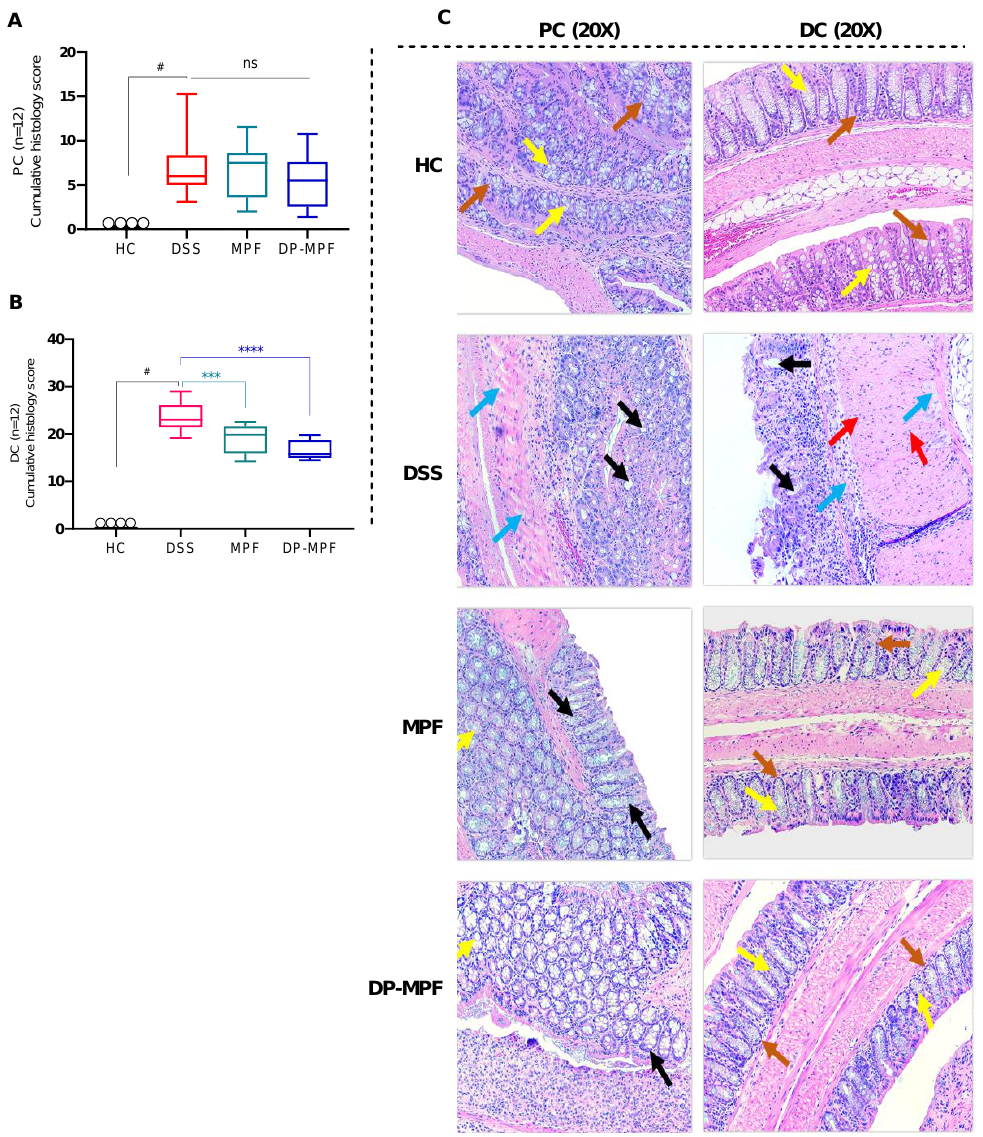
Figure 3. Effect of MPF and DP-MPF on histopathology in DSS-induced colitis. ( A , B ) Histopathological scores for each animal were calculated after microscopic analysis of tissue sections from the PC and DC. ( C ) Histological representation of PC and DC sections stained with haematoxylin and eosin (H&E) for healthy controls (HC), DSS-treated mice (DSS), MPF treated mice (MPF), and DP-MPF treated mice (DP-MPF) at 20 × magnification. Statistical significance was evaluated using one-way ANOVA followed by Tukey’s post-test. # Significant effect HC vs. DSS ( p < 0.05). A p -value of <0.05 was considered significant, ns indicates non-significance, *** p < 0.001 and **** p < 0.0001. Data expressed as a mean ± SEM ( n = 12/group). Arrows represent crypts/regeneration of crypts (brown), goblet cells (yellow), epithelium surface erosion (black), inflammatory cells infiltration (red) and submucosal oedema